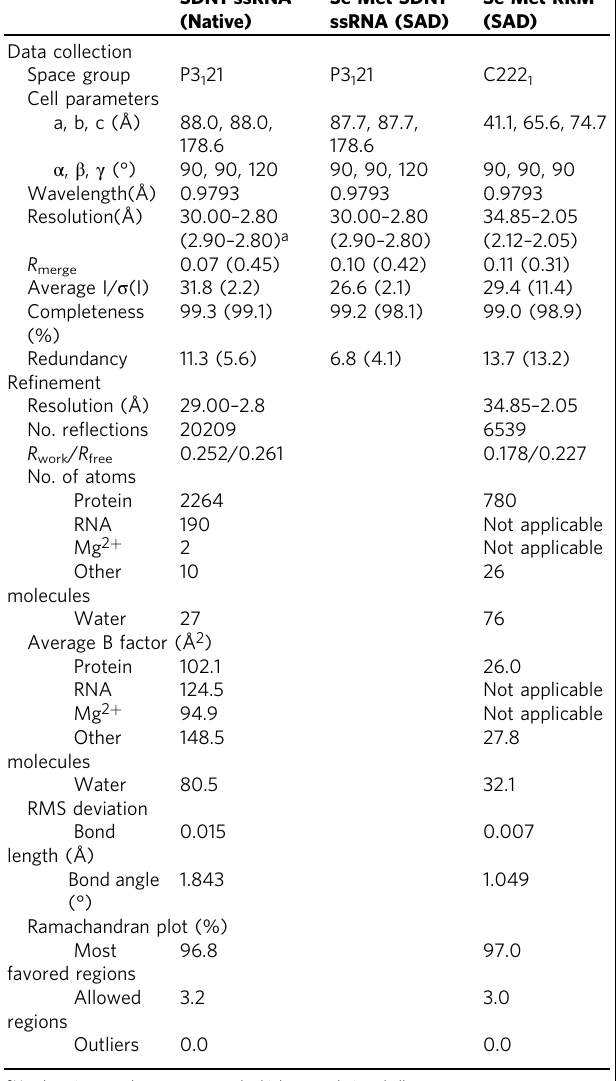
Table 1 Data collection and re fi nement